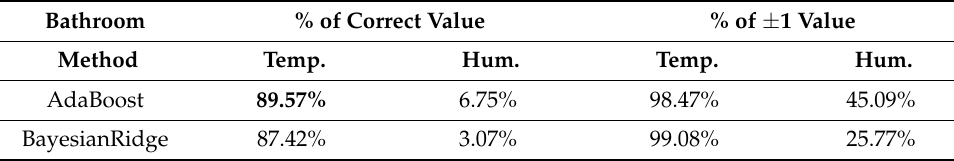
Table 4. Evaluation of algorithms for the measurements